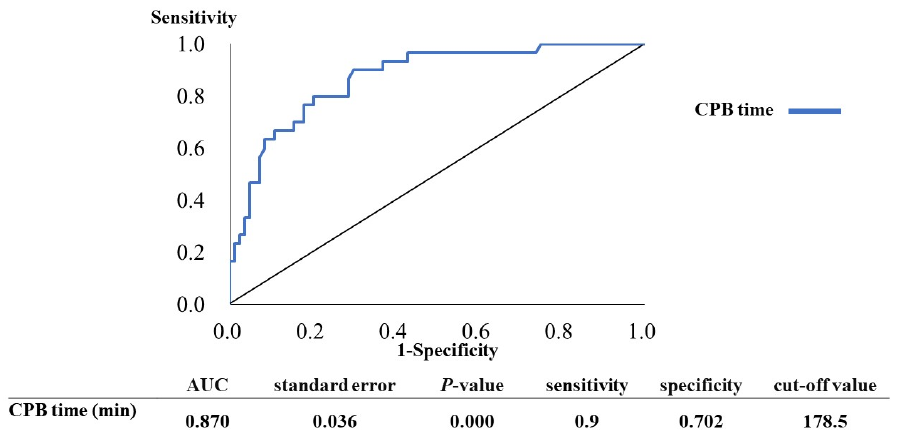
Figure 2. ROC curves to identify the optimal cutoff of CPB time for detecting AKI. To generate the ROC curves shown, CPB time cutoffs were used to predict AKI, with true positives plotted on the vertical axis (sensitivity) and false positives (1 – specificity) plotted on the horizontal axis.